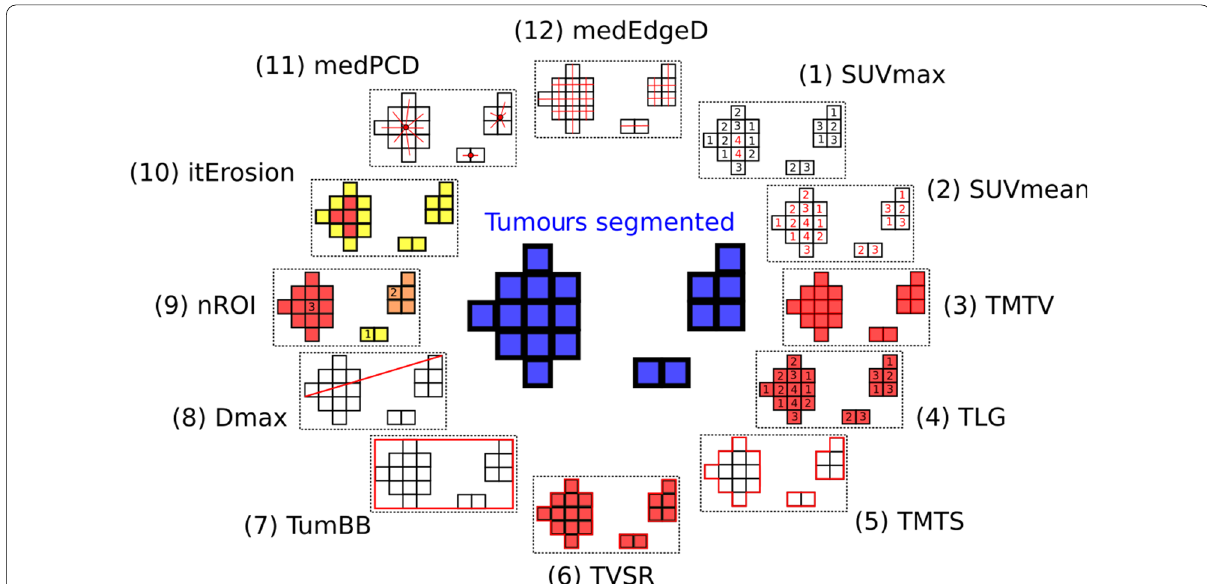
Figure 3 Representation of the twelve different PET parameters measured by the software Oncometer3D and analysing burden, activity, dispersion, fragmentation and massiveness of the lymphoma. For graphical purpose, a planar representation of these 3D parameters is